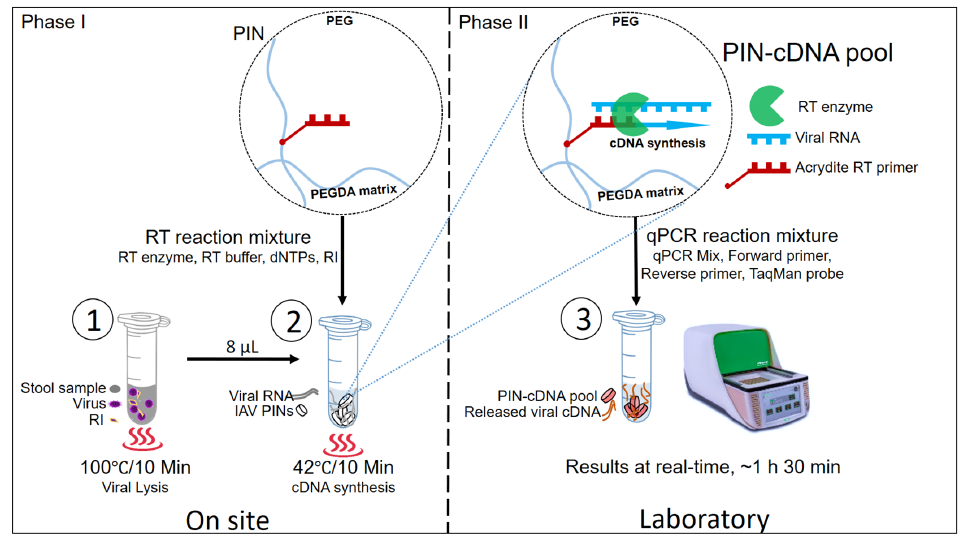
Figure 1. The schematic presentation of three main steps for PIN particles as viral RNA carriers for qPCR.